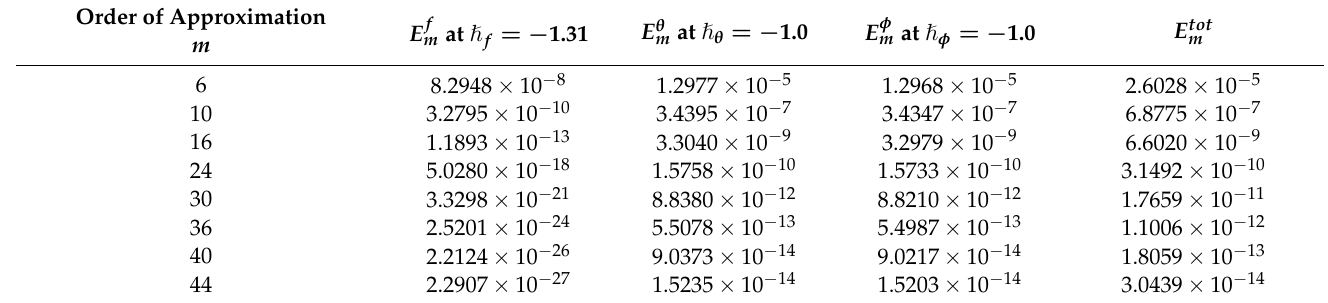
Table 3. Average residual error of mth -order approximation of OHAM steady-state solution β = 0.1,